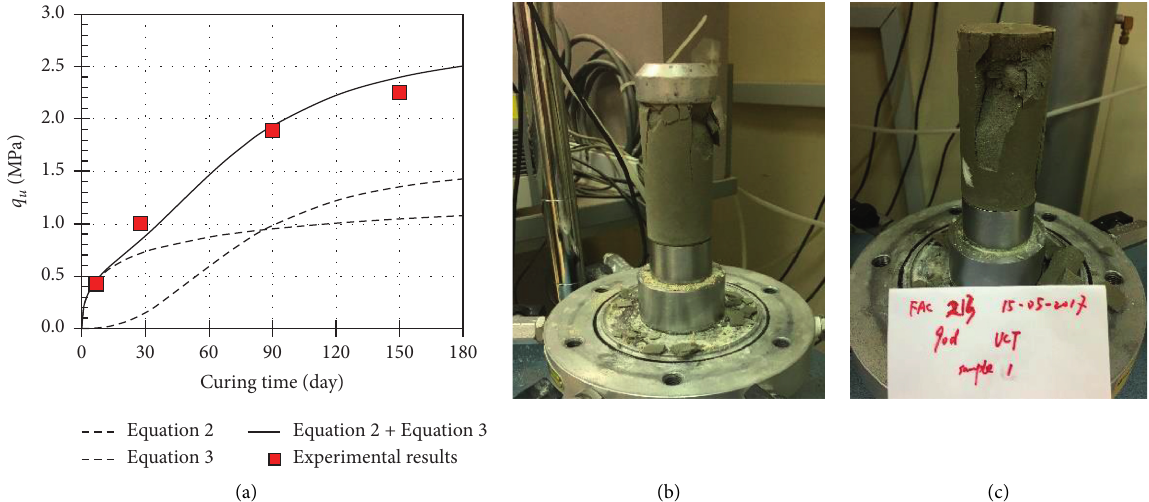
Figure 4: (a) Validation of the strength prediction model, and (b) and (c) samples after the unconfined compression test with 28-day and 90- day curing periods,